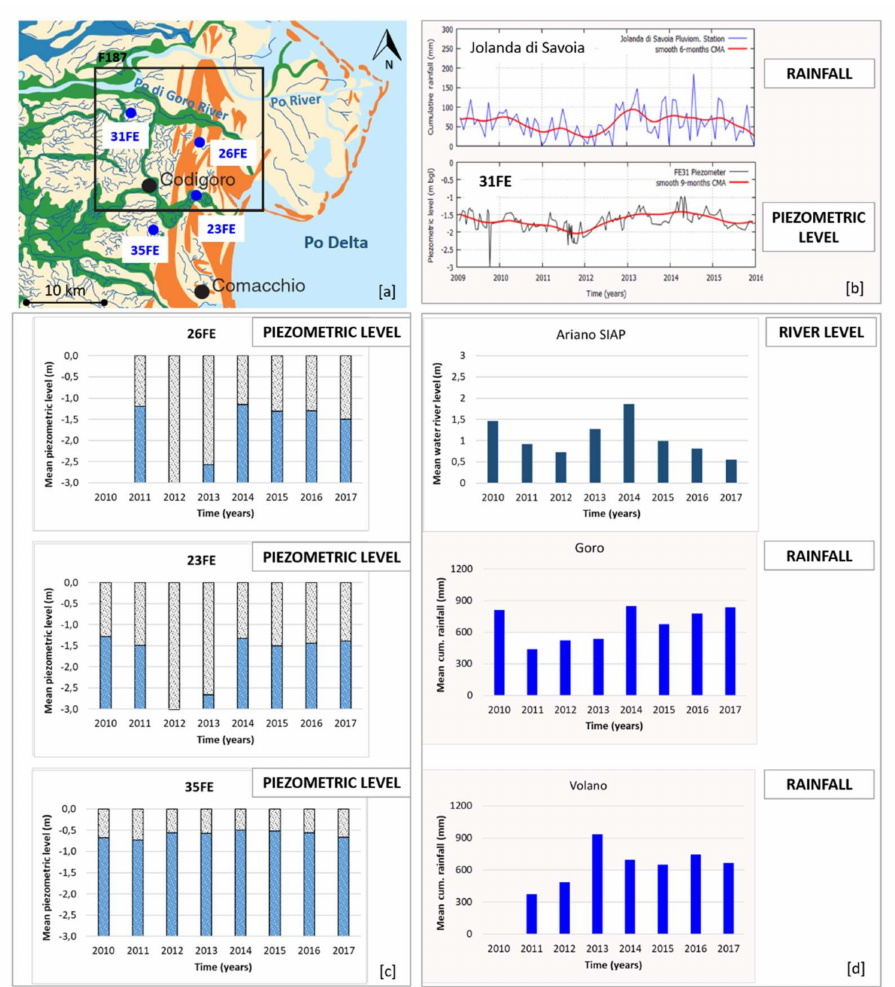
Figure 6. Hydro-meteorological and hydrogeological data used in Step 2. ( a ) Geological map of Po River Delta and location of the analyzed piezometers (blue dots). The map has been modified from F. 187 - Codigoro [35] and coloured areas represent ancient coastal sands and delta front (orange), inter-distributary bay deposits of lower delta plain (light-yellow), distributary channels of the Po (green) and Adige (blue) Rivers. Black square represents F. 187 outline. ( b ) Smoothed CMA of Jolanda di Savoia pluviometric station and 31FE piezometer. ( c ) Mean annual values of piezometric levels collected at 26FE, 23FE, and 31FE boreholes. ( d ) Mean cumulative annual values of daily water river level collected at Ariano SIAP hydrometric station and rainfalls referred to Goro and Volano pluviometric stations (see Figure